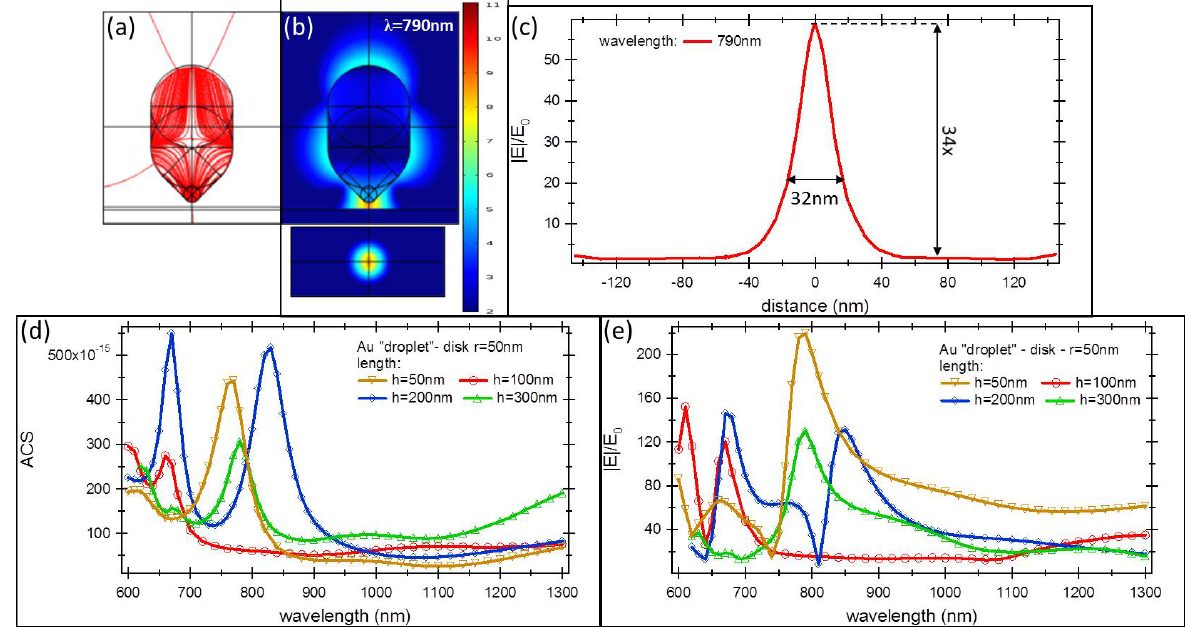
Figure 4: Droplet transducer. The quadrupole electric field lines (a) and electric field profile (logarithmic scale) (b) through a cross-section of the droplet transducer for h = 50 nm and wavelength of λ = 790 nm. (c) Electric field distribution along the width direction of the droplet transducer through the center at distance of 7 nm from transducer and normalized to E 0 . (d) Absorption cross-section and (e) electric field